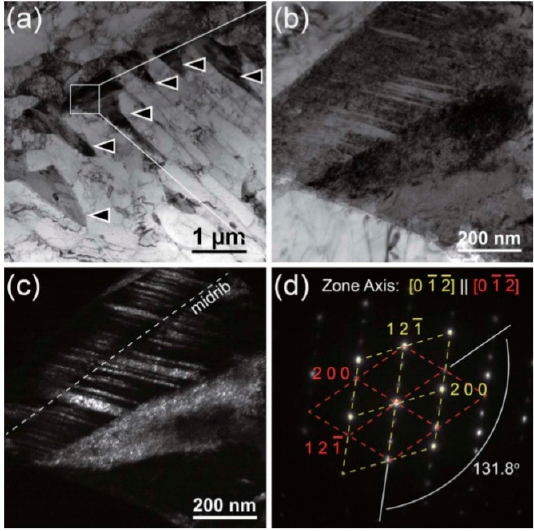
Figure 9. TEM micrographs showing the fine structure of M/A phases in S690Q steel after tempering at 720 °C. ( a ) Bright-field image at low magnification, ( b ) bright-field image, ( c ) dark-field image, and ( d ) electron diffraction pattern.